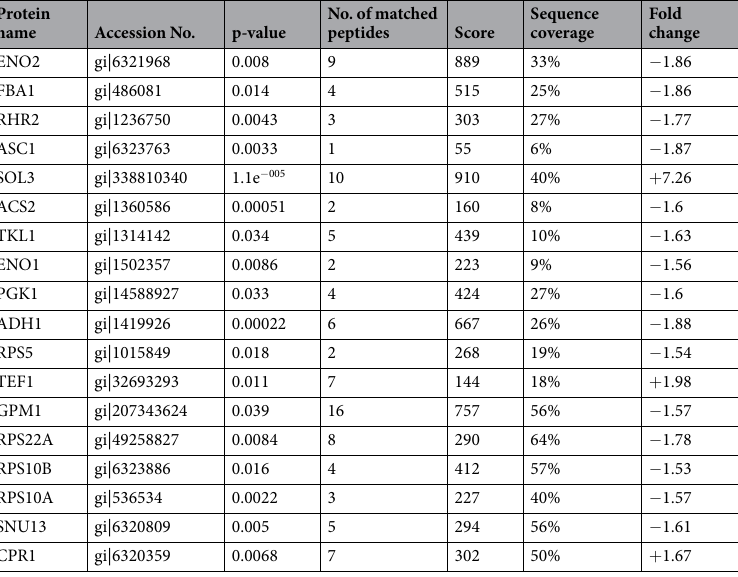
Table 1. Identification of differentially expressed proteins in a RRP8 deletion strain compared to its isogenic wild-type